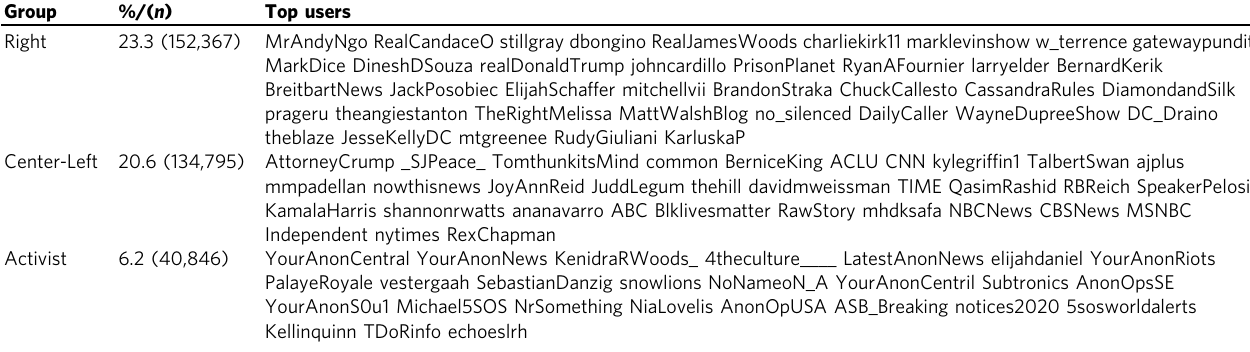
Table 1 Representative sample of top posters for each group, post-clustering, and imputed name.